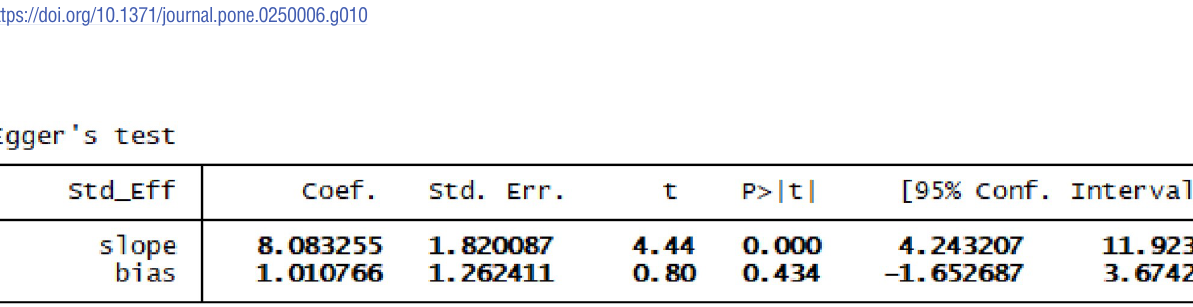
PLOS ONE | https://doi.org/10.1371/journal.pone.0250006 April 22, 2021 14 /